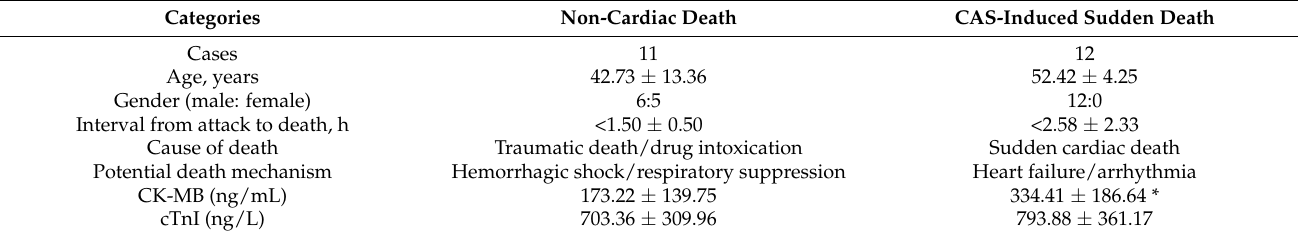
Table 4. Baseline characteristics of collected forensic samples from the two groups of decedents.